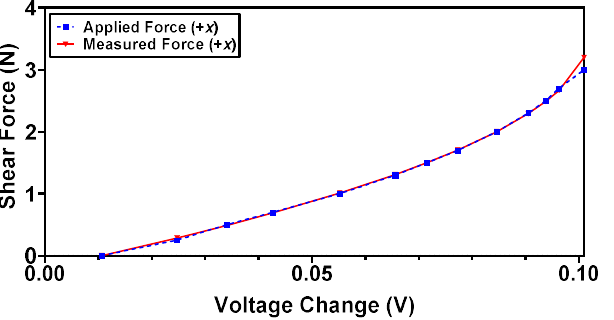
Figure 17. Measured vs. applied force in shear +x -direction using the back interpolation mathematical model.